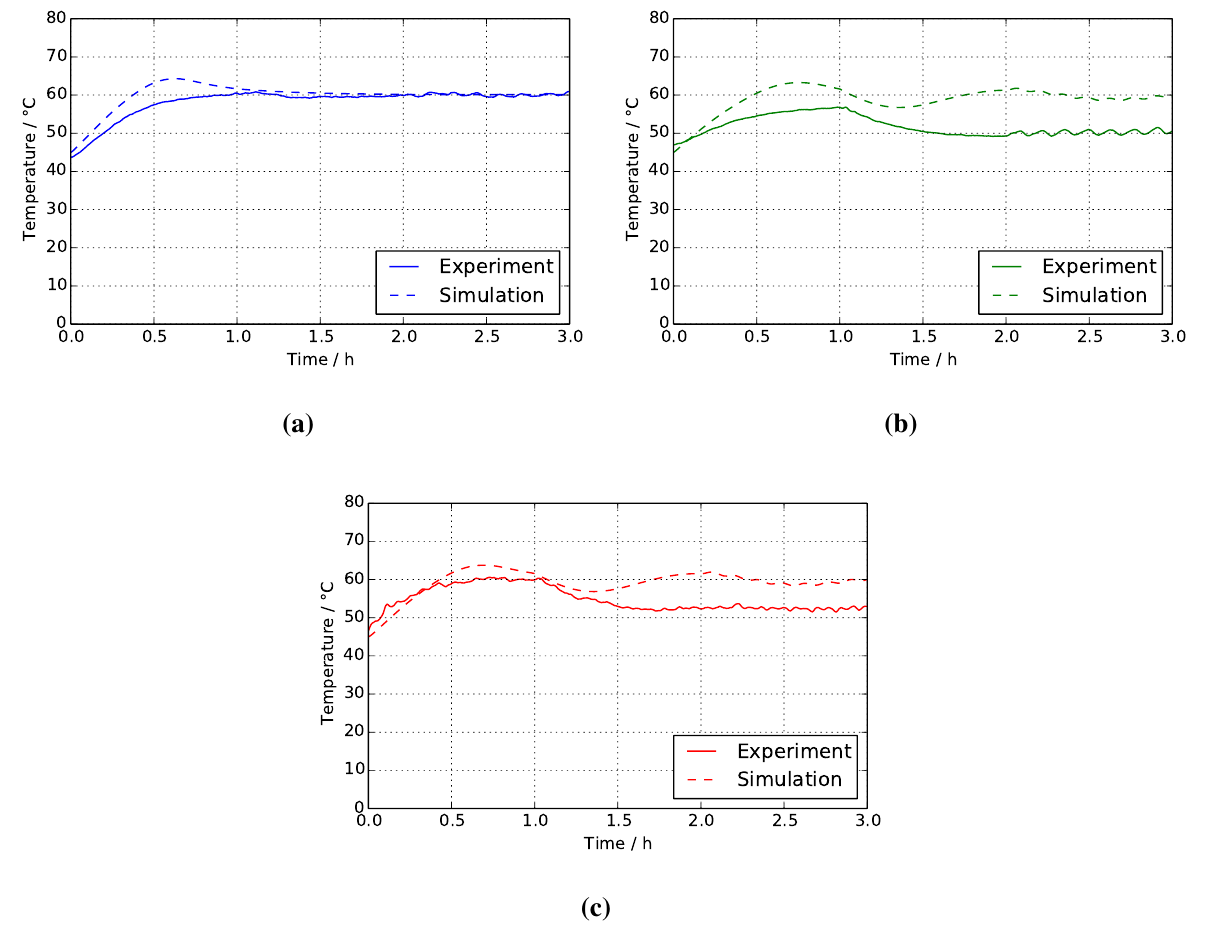
Figure 8. The temperature profile of the stack in all considered systems: ( a ) reference system; ( b ) two-mixer system; ( c ) separate tanks